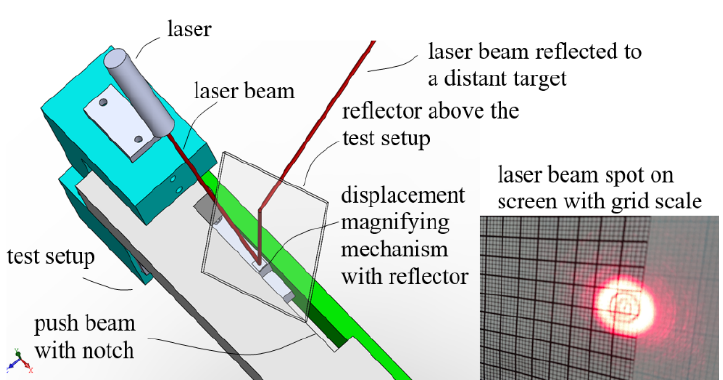
Figure 18. Optical lever setup illustration and a photograph of the laser spot on a distant screen.